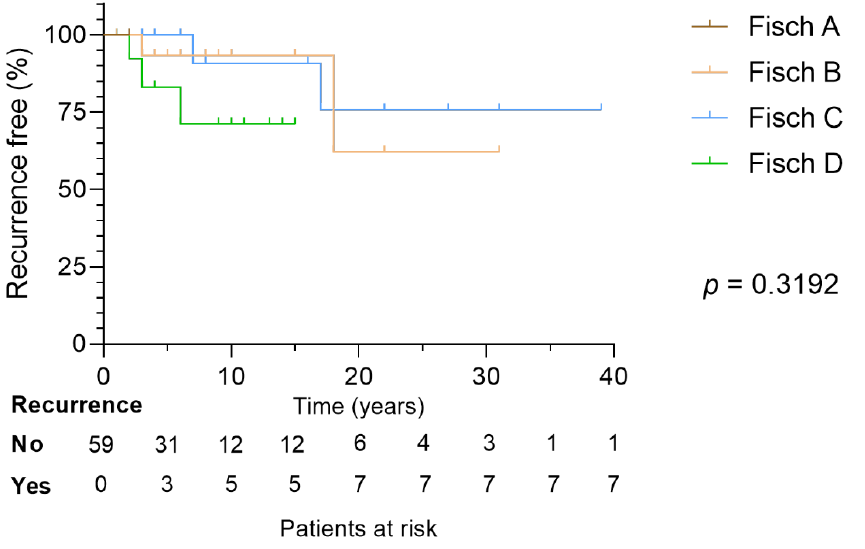
Figure 5. Kaplan–Meier curve and log-rank test of recurrence free patients over the long-term follow-up period. No significant differences between Fisch A to D TBPs were observed ( p = 0.3192). TBP—temporal bone paraganglioma.